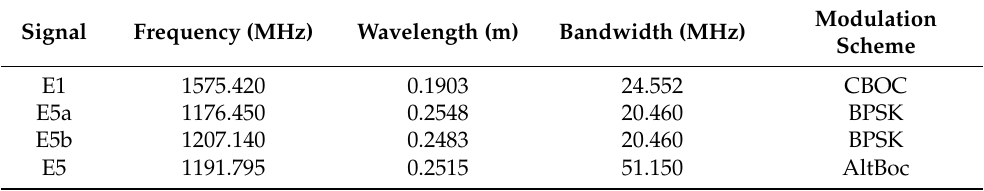
Table 2. Galileo frequencies and